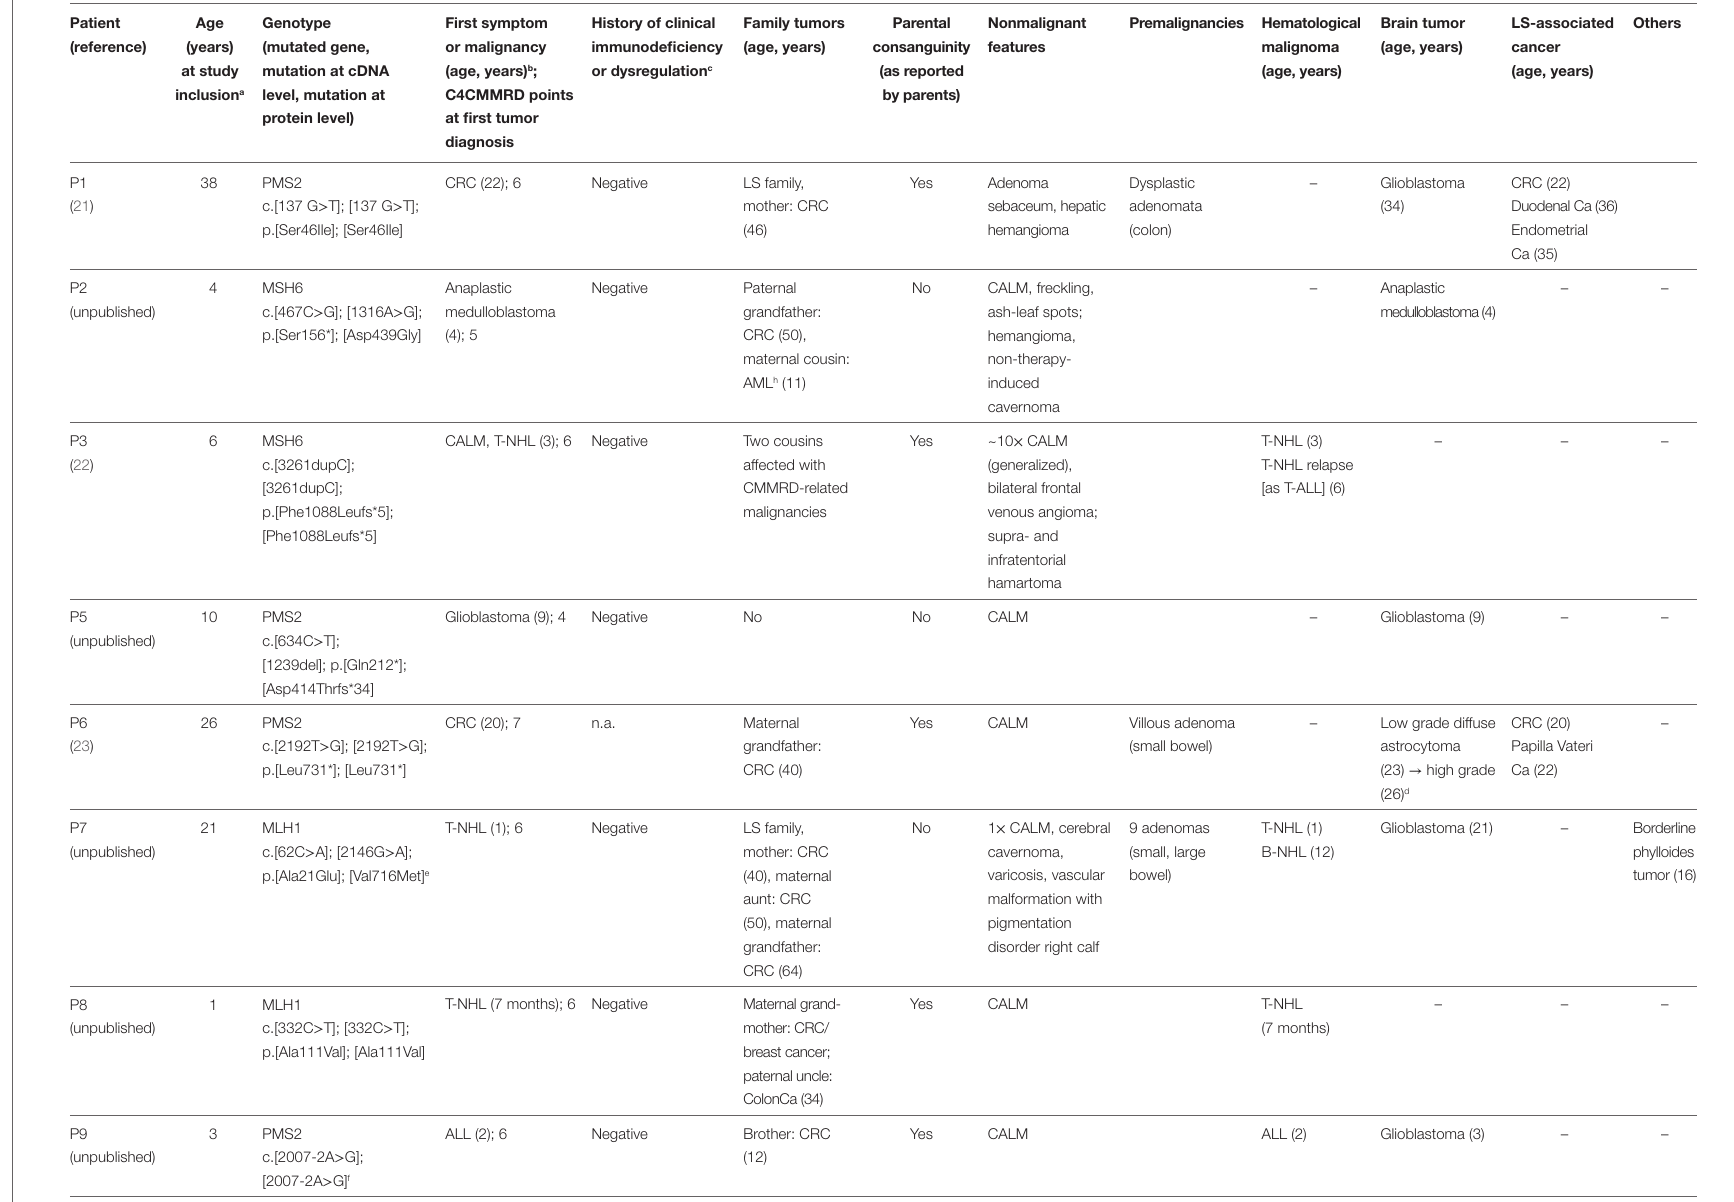
TaBle 1 | Characteristics of 15 patients with